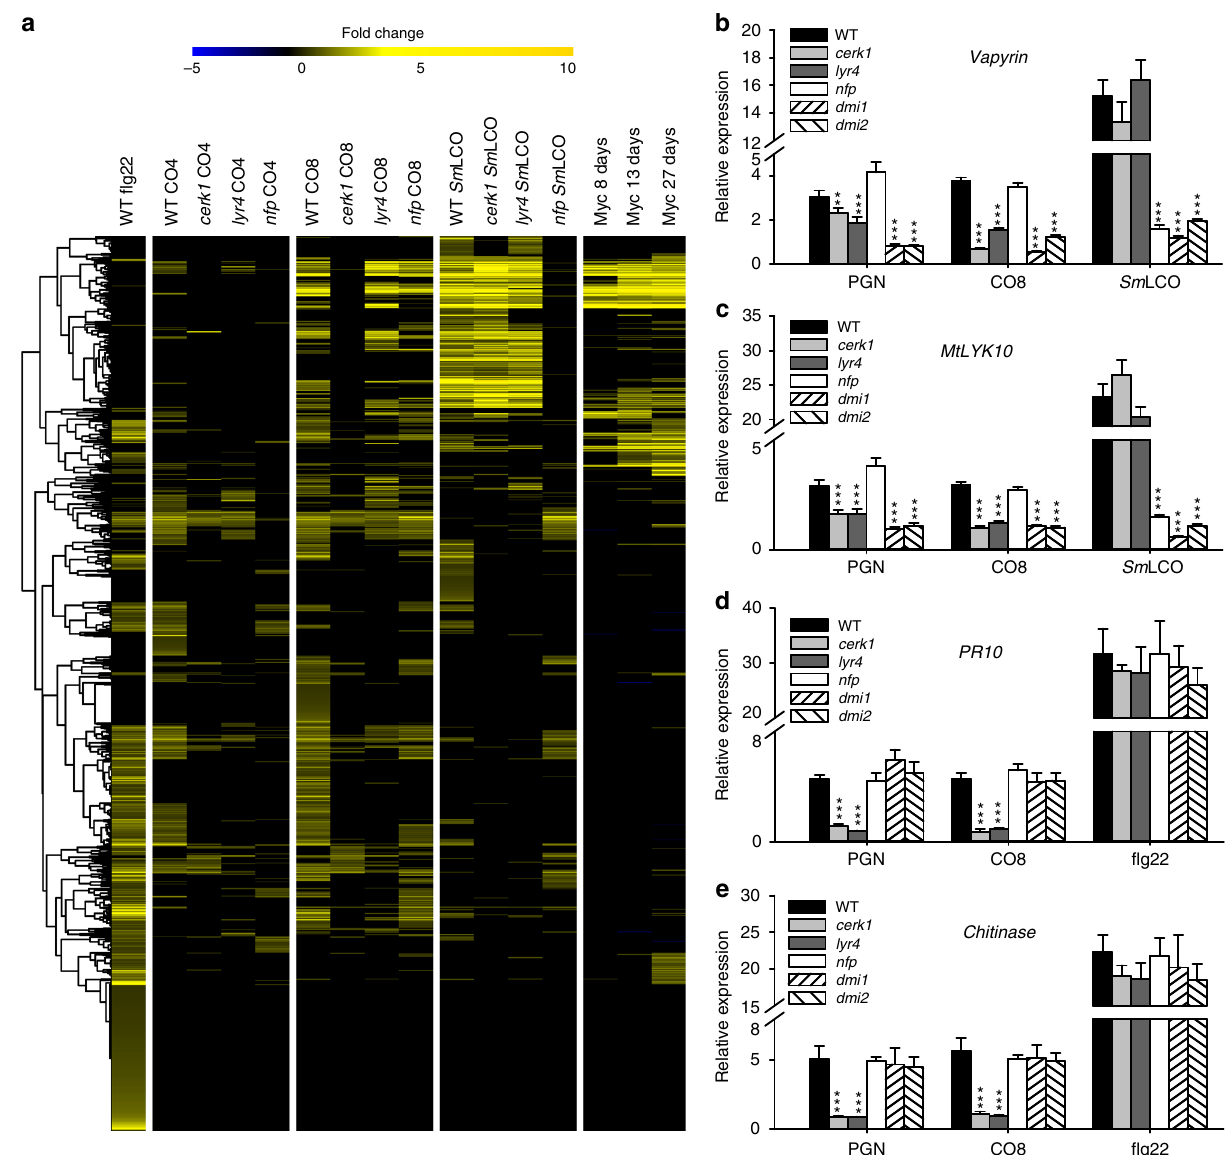
Fig. 4 MtCERK1 and LYR4 are required for CO8 and PGN-induced gene expression. a A heat map of genes induced by fl g22, CO4, CO8 and Sm LCO (6 h treatment). The expression of these genes in mutants and during mycorrhizal colonization is shown. qRT-PCR validation of representative symbiotic genes ( b and c ) and defense genes ( d and e ) induced by PGN, CO8, Sm LCO and fl g22. M. truncatula wild type and mutant roots were treated with 0.4 mg/ml repeated three times with similar results (mean ± s.e.m.; n = 3; signi fi cant difference relative to wild type by Student ’ s t -test, *** P < 0.001; ** P <